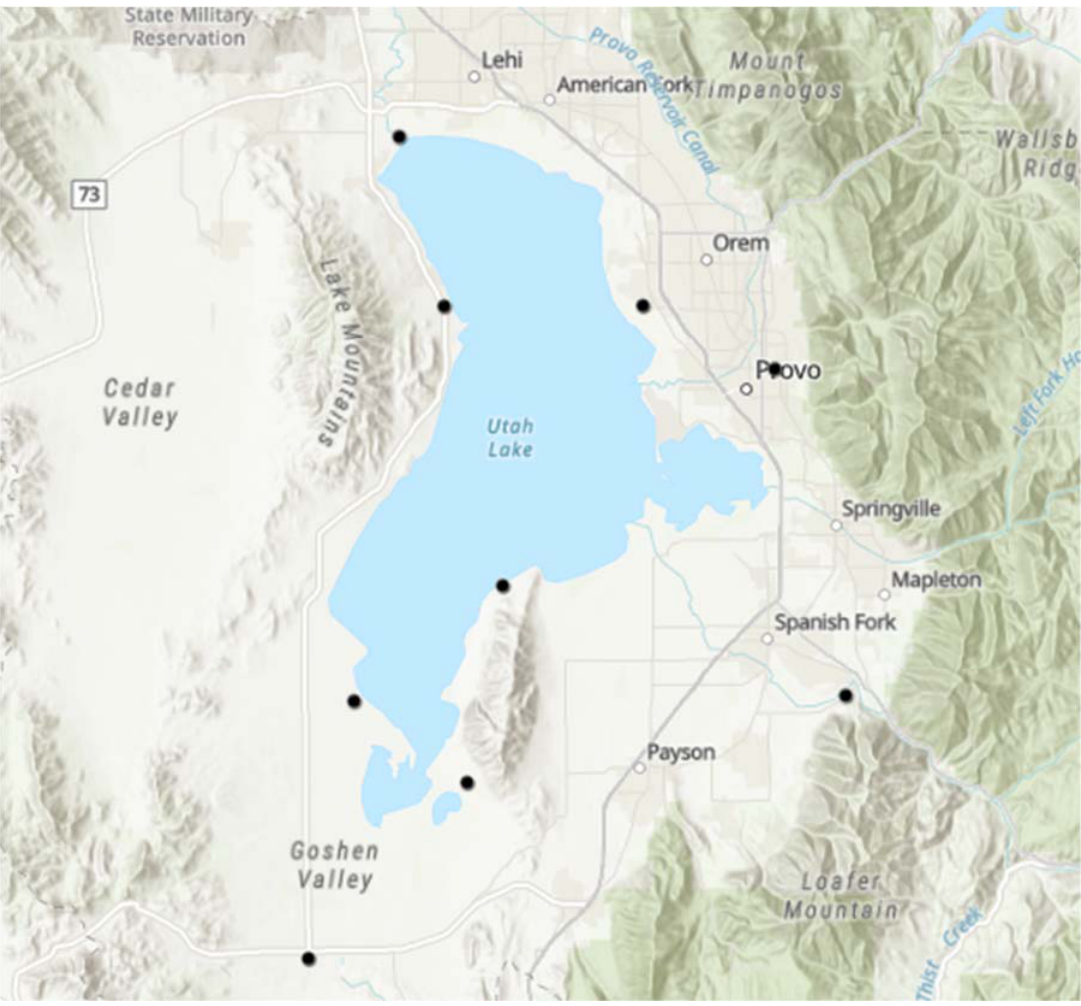
Figure 2. Utah Lake BYU Stations.